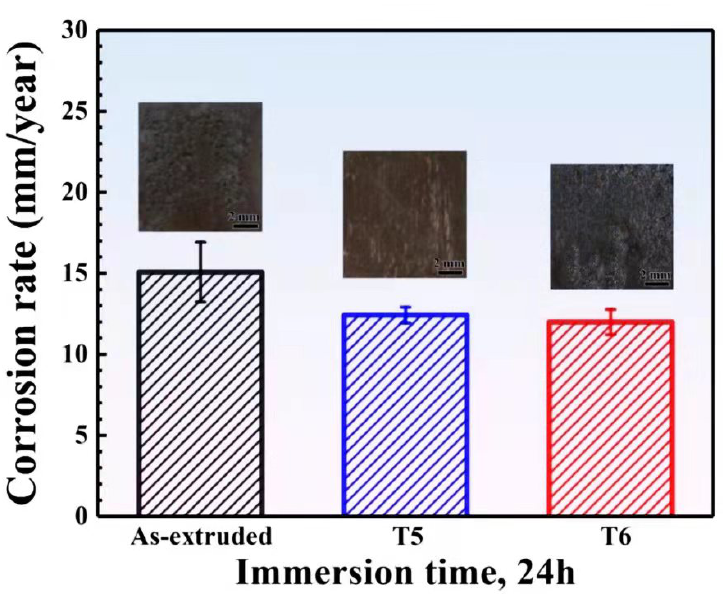
Figure 5. Corrosion rates of the as-extruded, T5- and T6-treated Mg-11.46Gd-4.08Y-2.09Zn-0.56Zr alloys estimated by weight loss method.